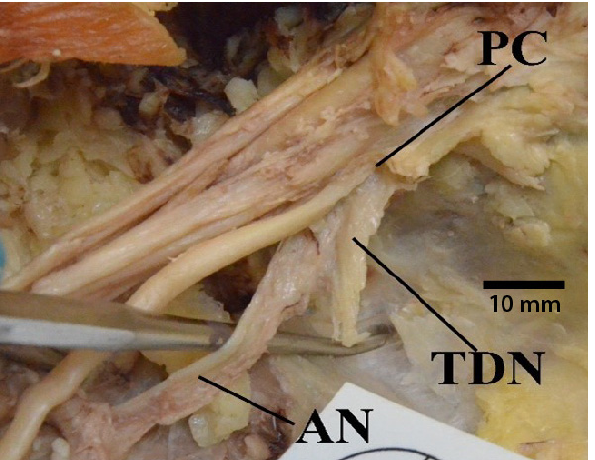
Figure 11. Photograph of the variant in which the thoracodorsal nerve originates from the axillary nerve. Abbreviations: AN = axillary nerve; PC = posterior cord; TDN = thoracodorsal nerve.